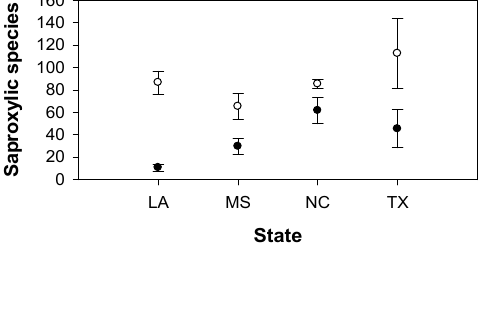
Figure 4. Mean ± SE ( n = 3) saproxylic beetle abundance in reference and dead wood plots (closed and open circles, respectively) by state in